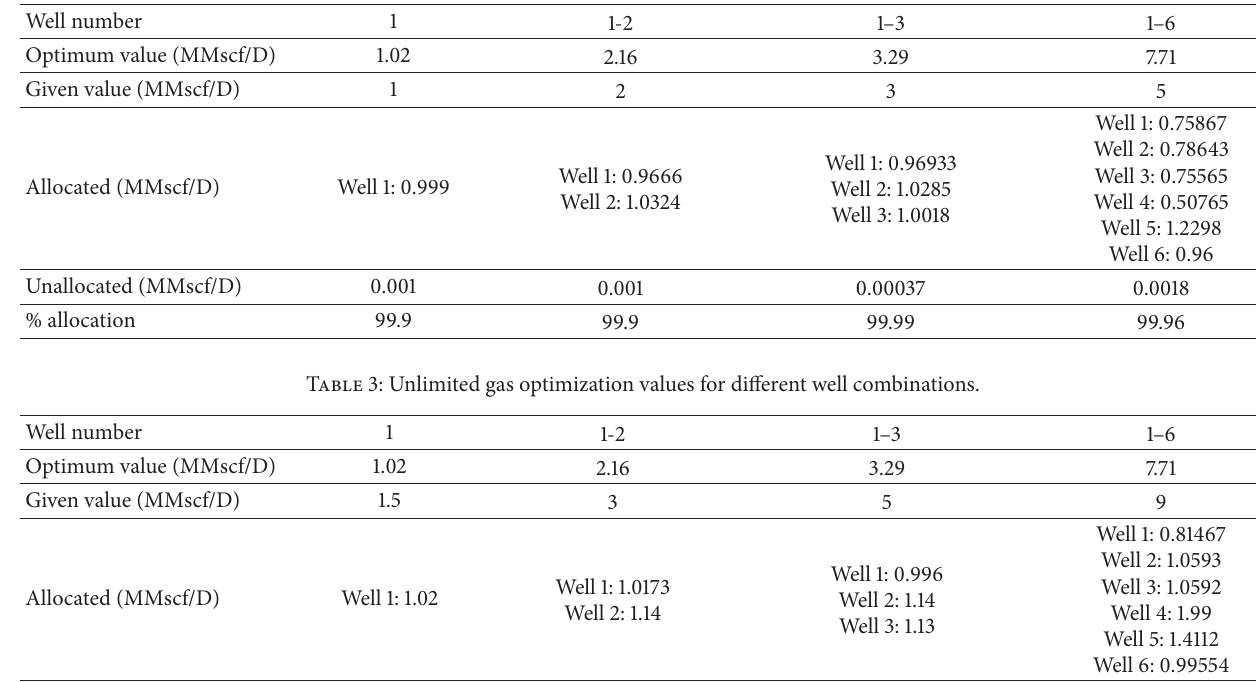
Table 2: Limited gas optimization values for different well combinations.